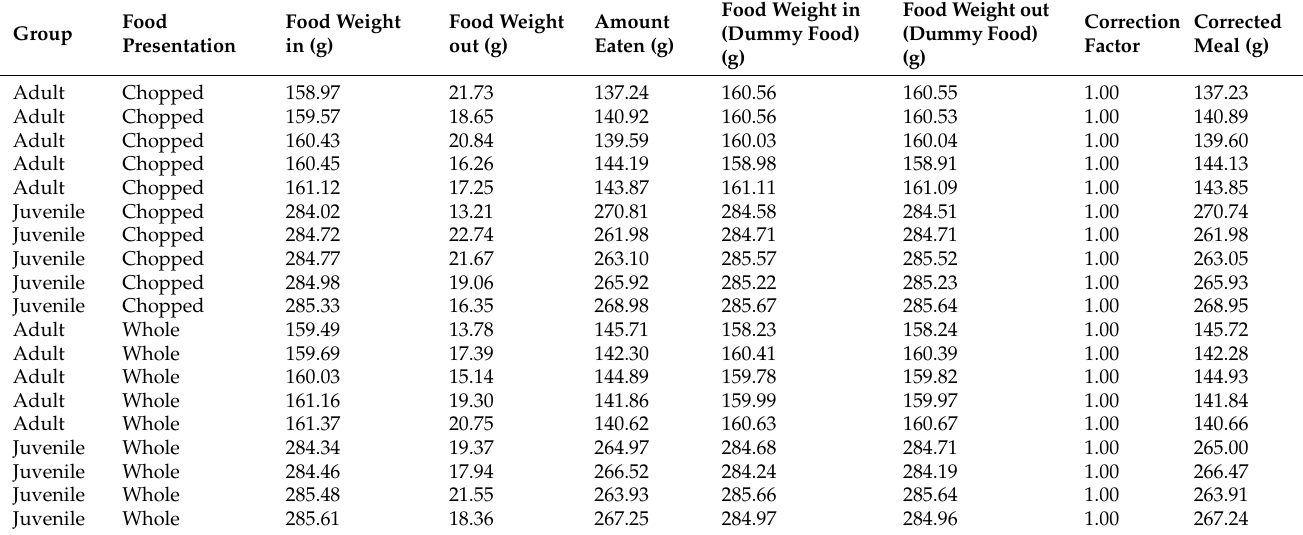
Table A1. Table of food weights (including dummy food) and correction factors used to take into account evaporation and